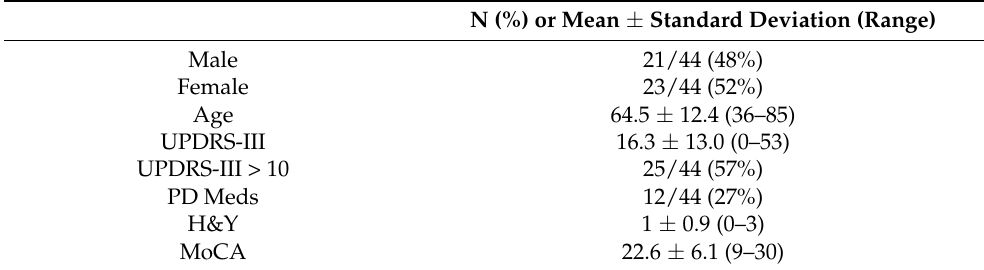
Table 1. Demographics and questionnaire results for patients enrolled in the